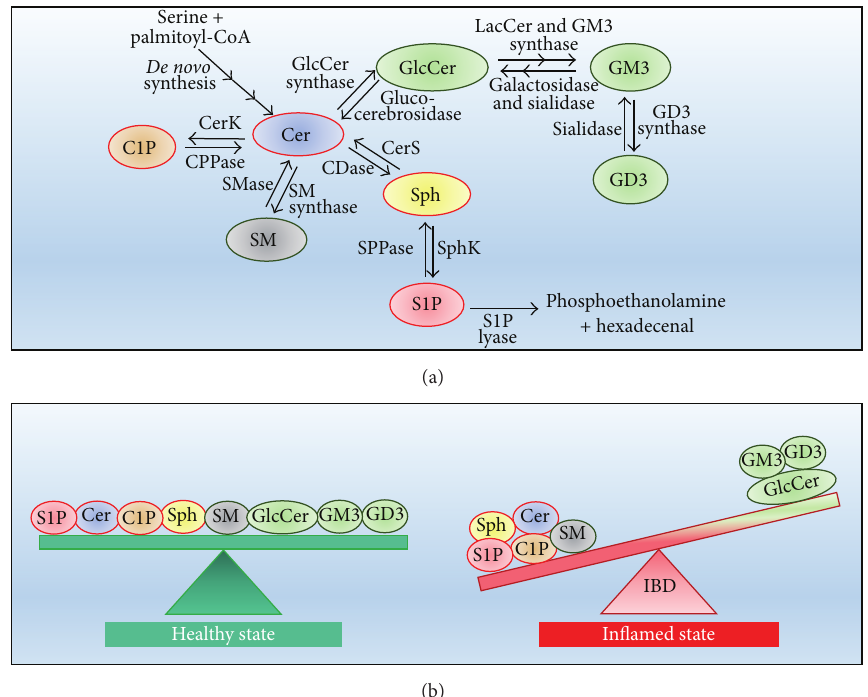
Figure 2: Metabolism and balance of intestinal sphingolipids in physiological conditions and IBD. (a) Interconnected pathways of intestinal sphingolipid metabolism. (b) In the healthy state, intestinal sphingolipids are in a “functional equilibrium” (left); in the inflamed state of IBD, an unbalance of this equilibrium occurs, favoring the inflammatory disease